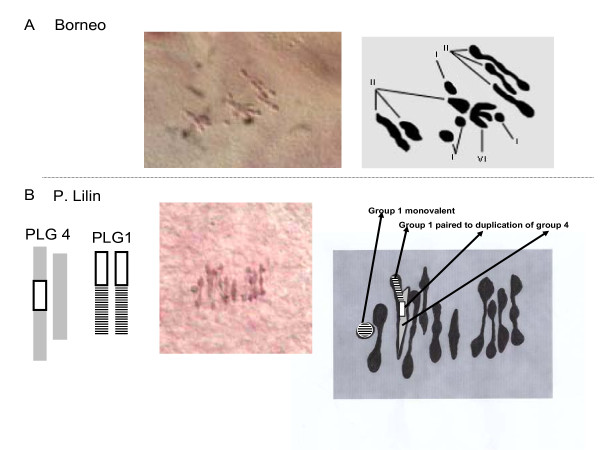
Views of chromosome pairing during meiosis (metaphase I) and their diagrammatic illustration. A - Borneo: the plate represents 4 monovalents (I), 6 bivalents (II) and one hexavalent (VI). The hexavalent is the result of association of three bivalents likely by their distal segments. B - P. Lilin: The plate shows 1 monovalent, 9 bivalents and 1 trivalent displaying a Y shape. This pattern suggests a connection point located in the proximal position.